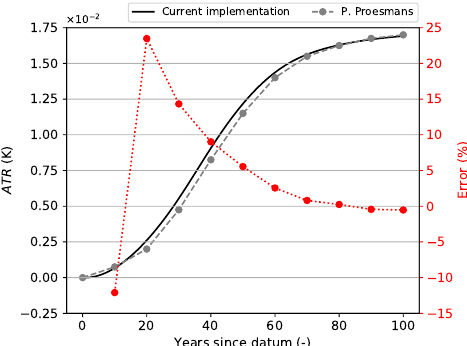
Figure 1. Verification of climate impact model (dashed grey reference data from